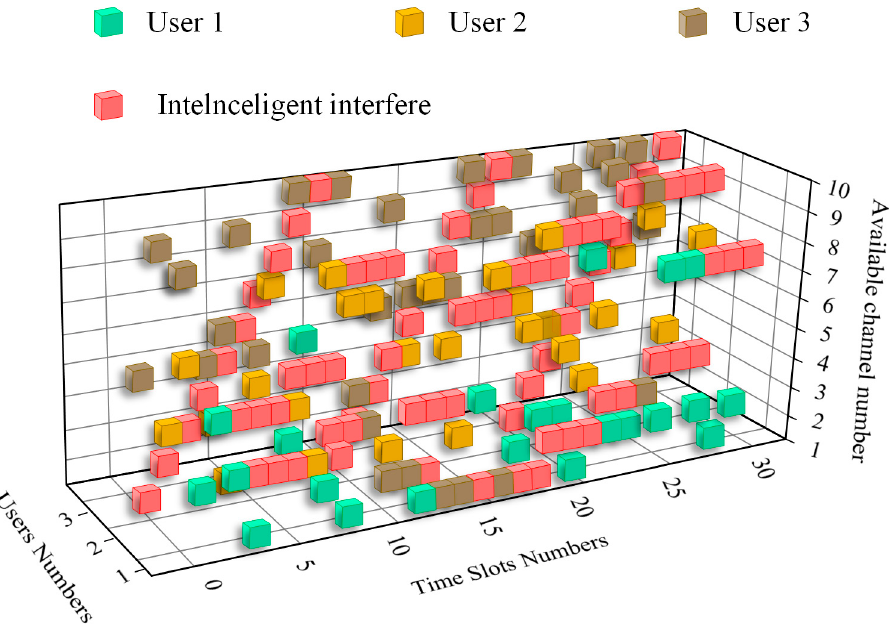
Figure 7. Real interference-communication diagram of a 3-user system with a central base station.